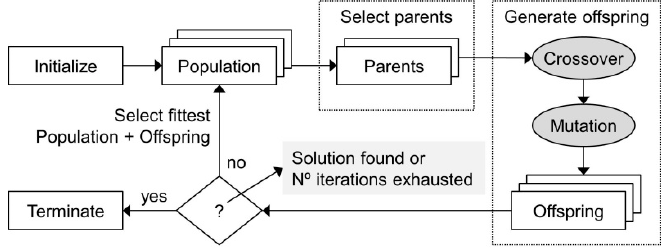
Figure 3. The evolutionary process of a genetic algorithm (GA).